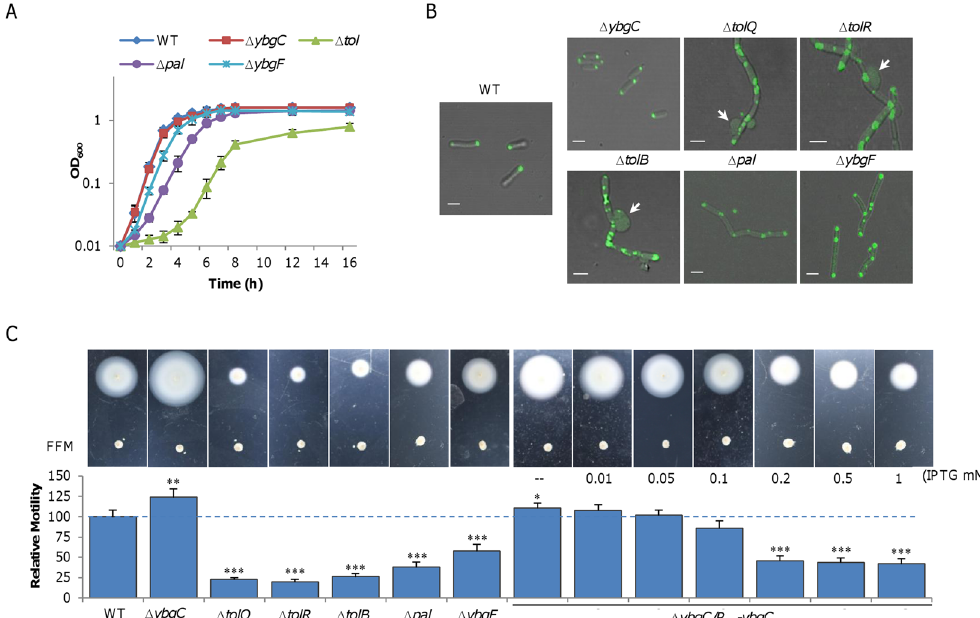
Figure 2. Characteristics of S. oneidensis mutants for genes in the tol - pal cluster. ( A ) Growth under aerobic conditions. Shown were wild-type (WT) and its isogenic mutants. The fresh medium was inoculated with mid- log phase cultures ( ∼ 0.3 of OD 600 ) for each strain. Both LB (shown) and MS defined medium were used and similar results were obtained. ∆ tol represents all tol mutants ( ∆ tolQ , ∆ tolR , and ∆ tolB ) because growth defects in these strains were similar. ( B ) Morphology of cells expressing FlhF-GFP. Cells of indicated strains grown to the mid-log phase in LB broth were examined for morphological phenotype and FlhF localization with a confocal microscope. Arrows highlight clear examples of blebs found in tol mutants but not other mutants. The scale bar represents 1 µ m in all panels. ( C ) Motility on the semi-solid agar plates. Strains indicated were grown to the mid-log phase were spotted on plates along with nonmotile FFM (flagellin-free mutant) and incubated for 16 h. Complementation of the ∆ ybgC strain by inducible expression from pHGE-P tac was performed with IPTG ranging from 0 to 1 mM. Relative motility for each mutant was given by setting the motility of WT (the diameter) as 100%. Asterisks indicate statistically significant differences ( * P < 0.05; ** P < 0.01; *** P < 0.001; n ≥ 3). All experiments were performed at least three times with either representative results shown or with the standard error of the mean (SEM) presented as error